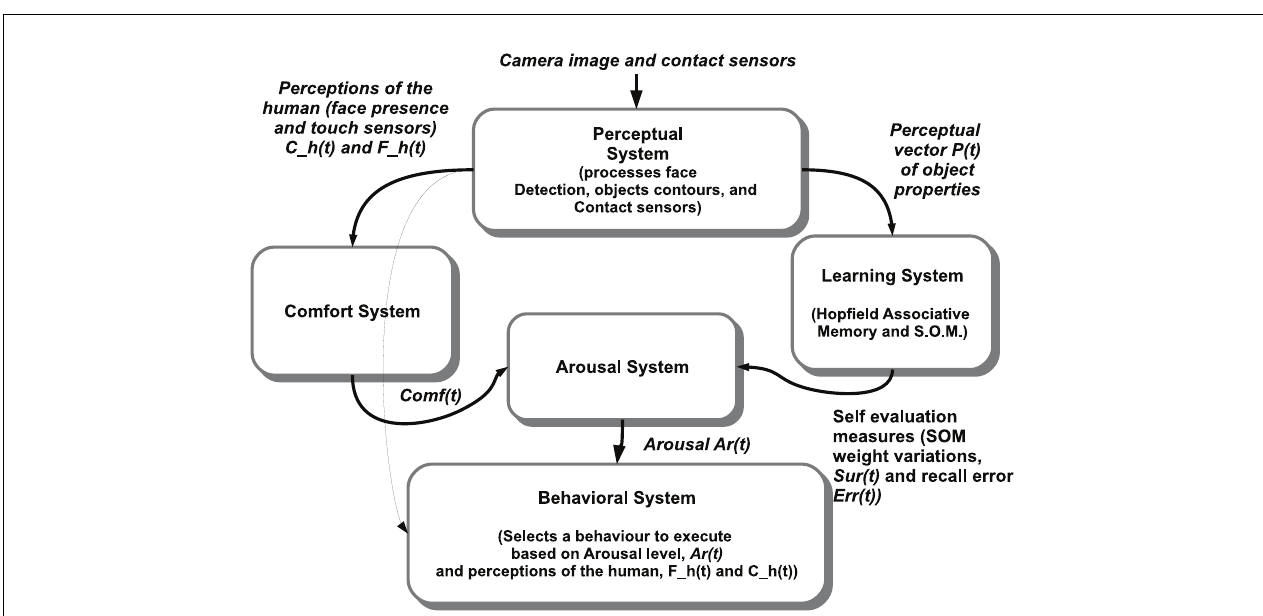
next. When the robot reaches end of the table, the direction of the movement is changed, and it then starts moving in the other direction. (A) Top view of the table and the robot during the experiment. (B) Schematic of the top view of the table and the robot during the experiment with the possible positions and their labels.